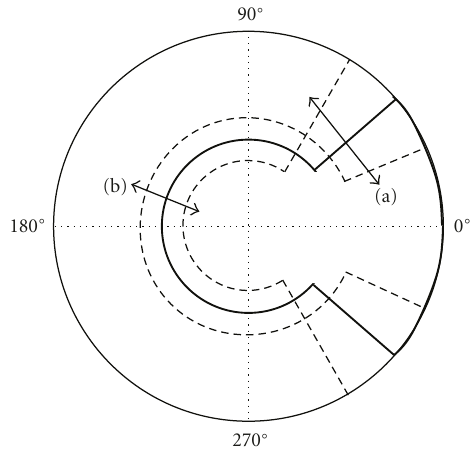
Figure 9: Schematic drawing of the possibilities to adjust the prop- erties of a directional noise reduction system using the proposed supporting algorithms: (a) beam width control using target signal detection algorithms and (b) maximum noise reduction using leakage control. The solid line represents an average setting and the dotted lines the range of adjustments, the radial axis denotes signal suppression arbitrary units.